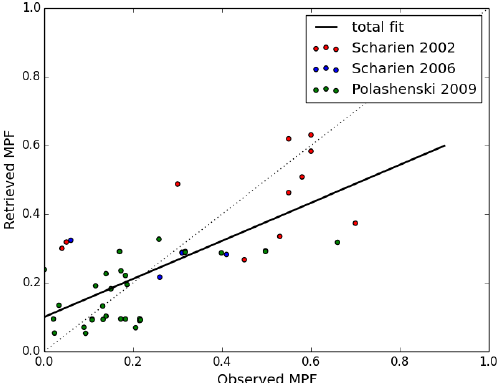
Figure 19. Three in situ campaigns on landfast ice: Scharien 2002 (red dots), Scharien 2006 (blue dots) and Polashenski 2009 (green dots). Total point number N = 47, RMS = 0.14, R 2 = 0.52. The overestimation of the low MPF may be connected to unscreened thin clouds which depending on the illumination-observation ge- ometry may appear darker than the ice and therefore cause higher retrieved